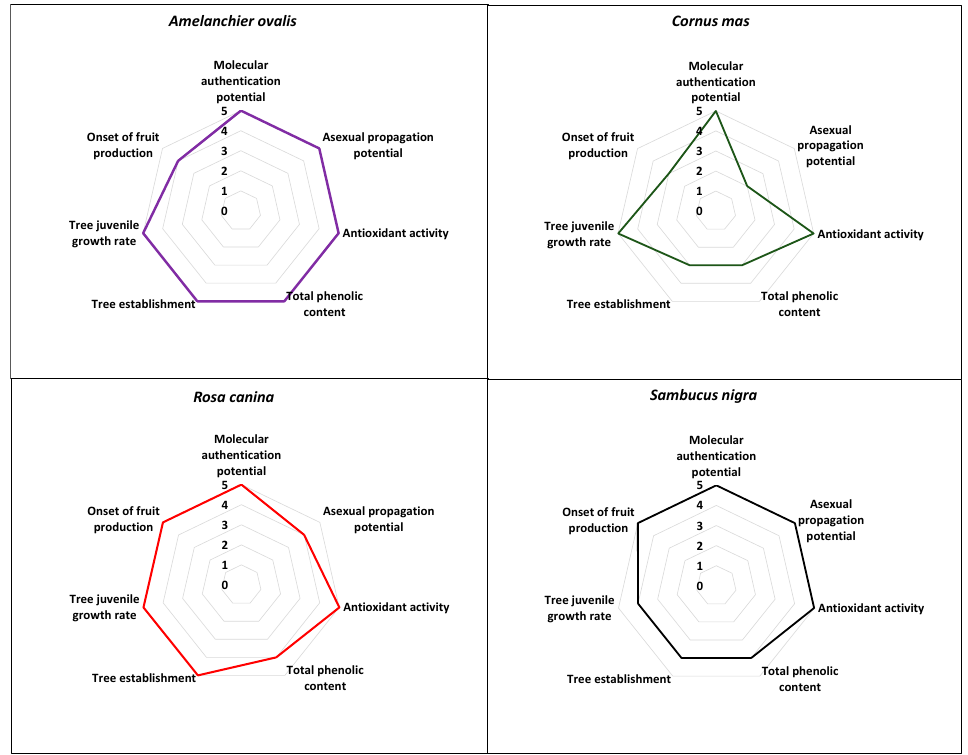
Figure 4. Comparative evaluation of the multifaceted potential of the four Greek native, neglected, and underutilized species ( Amelanchier ovalis , Cornus mas , Rosa canina , and Sambucus nigra ).